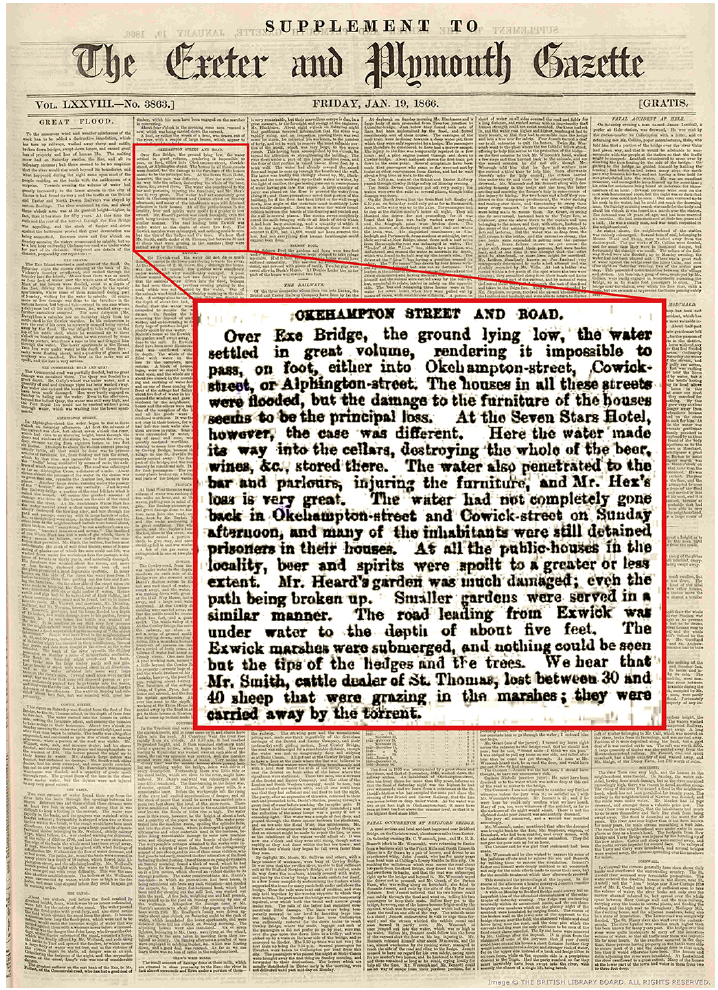
Figure 3. An example newspaper supplement dedicated solely to the flooding of the River Exe, January 1866. Enlarged section highlights the detailed local-level information contained within the supplement ( Exeter and Plymouth Gazette ,